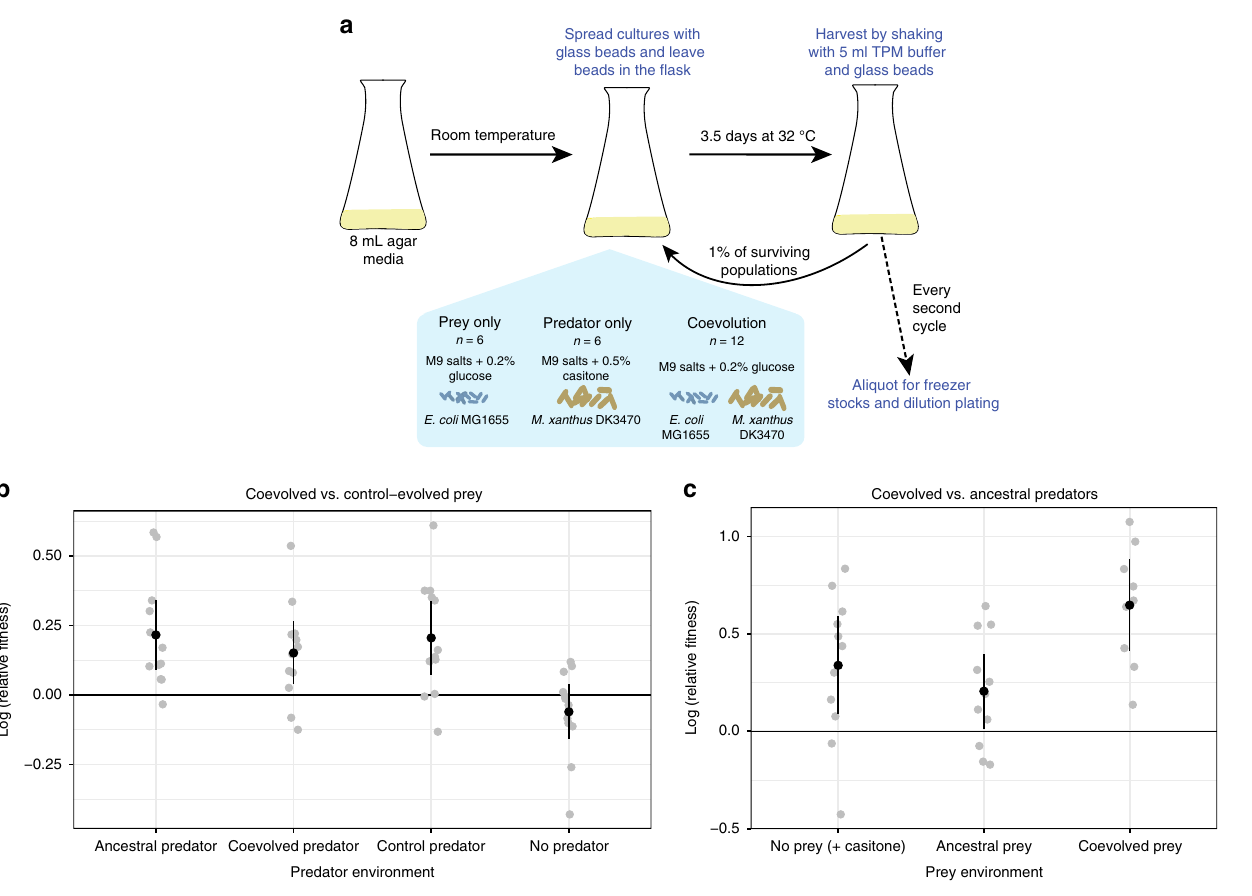
Fig. 1 Fitness patterns indicate adaptation speci fi c to the coevolution treatment. a Coevolved predator-prey communities (12) and control-evolved predator or prey populations (six each) were propagated on minimal medium supplemented with glucose or casitone. The fi gure was created by the authors. b Fitness of coevolved prey relative to control-evolved prey in direct competition experiments in the presence and absence of predators ( n = 12). c Fitness of coevolved relative to ancestral predators in direct competitions in the presence of prey and during growth on casitone in the absence of prey ( n = 12). Gray dots are population means, black dots are treatment means and error bars show 95% con fi dence intervals ( t -distribution). Source data are provided as a Source Data fi